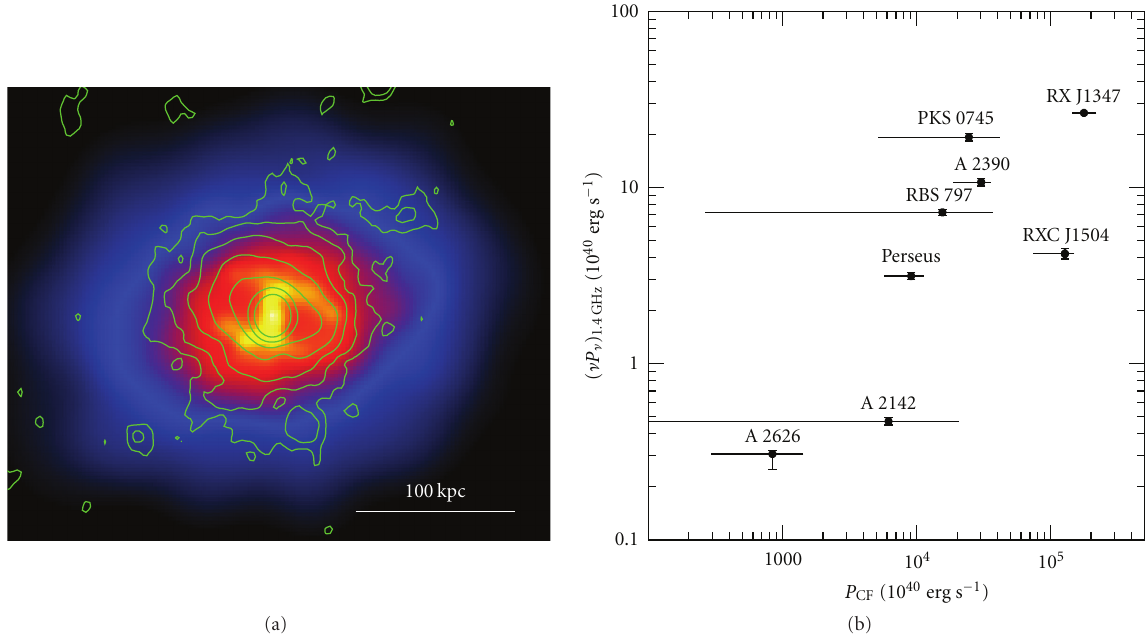
Figure 3: (a) 1.4GHz VLA radio contours (obtained by combining observations in A-, B-, and C-array configurations) overlaid onto the smoothed 0.5–2.0 keV Chandra X-ray image of the galaxy cluster RBS 797. The combined radio map has a resolution of 3 (cid:11)(cid:11) , and is able to reveal the morphology of the central radio source, showing its elongation in the cavity direction (see Figure 1(b)), without losing sensitivity at the larger scales. In particular, the extended radio emission is detected out to ∼ 90 kpc. By subtracting the contribution of the central nuclear source, the residual flux density of the di ff use radio emission is (cid:4) 11 . 5 ± 0 . 6mJy, indicating the likely presence of a radio mini- , versus cooling flow power, P CF = ˙ MkT/μm p , for the mini-halo clusters which have halo. (b) Integrated radio power at 1.4 GHz, [ ν P ν ] 1 . 4GHz relevant X-ray and radio data available (data from [111,